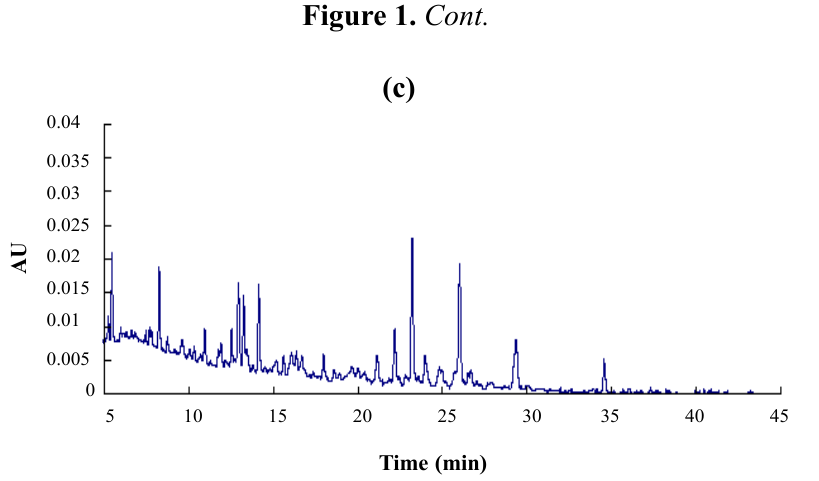
Figure 2. Proposed biotransformation pathway of polyphenol compounds in urine within 24 h, fed with LSOPC. 1 , LSOPC; 2 , catechin; 3 , caffeic acid; 4 , ferulic acid; 5 , m -coumaric acid; 6 , 3-hydroxyphenylacetic acid; 7 , 3-hydroxyphenylpropionic acid; 8 , syringic acid; 9 , 3-hydroxybenzoic